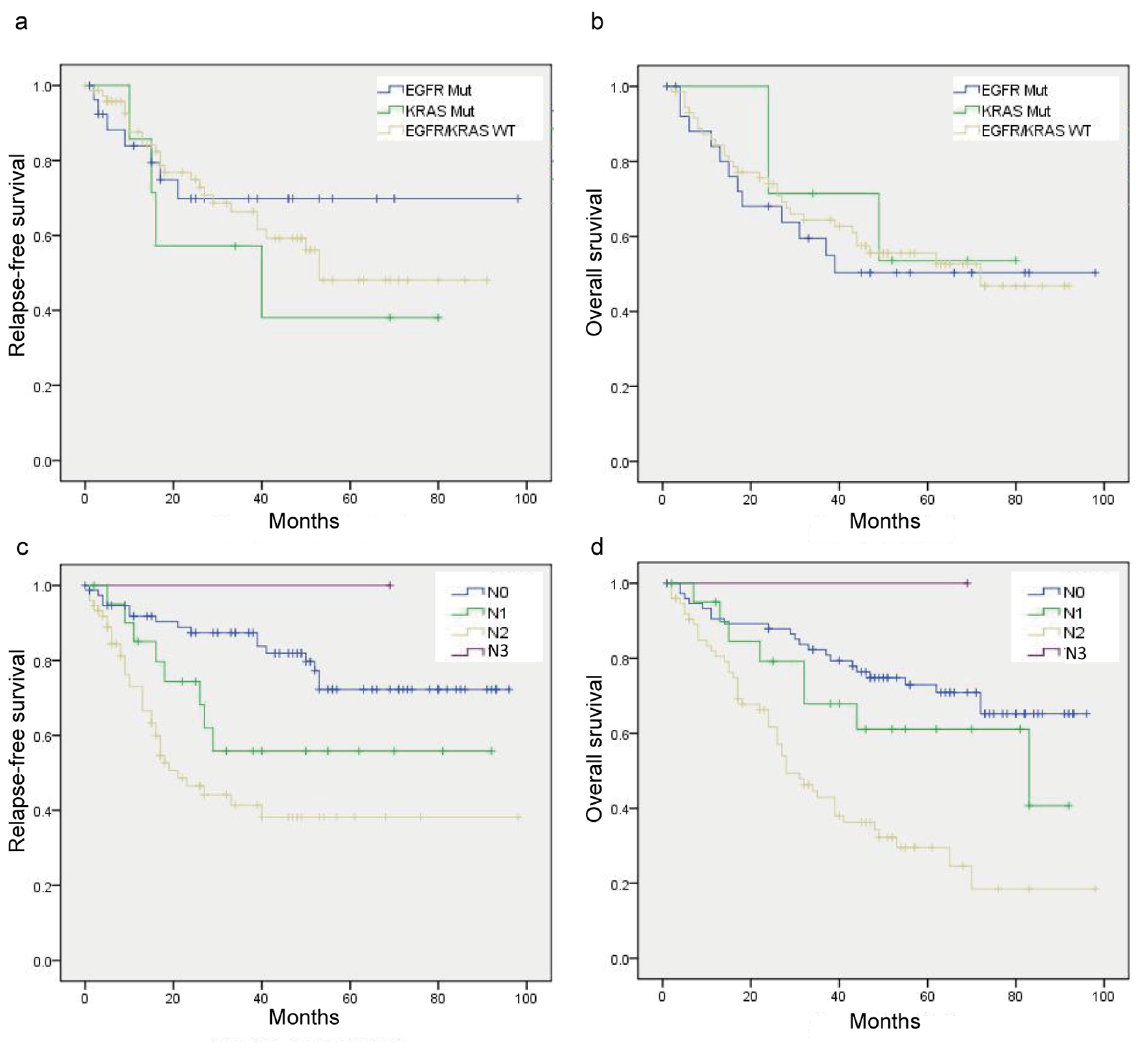
Figure 2. Relapse-free survival and overall survival in patients with NSCLC. a–b . EGFR and KRAS mutation status were not associated with relapse-free survival ( P =0.600) or overall survival ( P =0.873) in lung adenocarcinoma; c–d . Lymphnode stage (N stage) was significantly associated with relapse-free survival ( P =0.001) or overall survival ( P =0.001) in NSCLC.